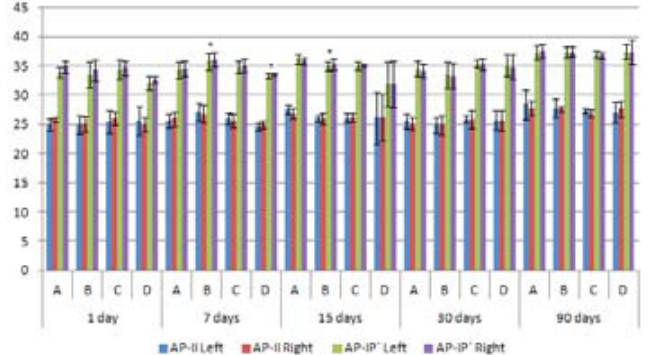
FIGURE 2 - Mean values and standard deviations (SD) of the cephalometric mensurations (mm) of the mandible of all the groups according to the experimental period. A=Control, B=DEX, C=MTX Low dose, D=MTX High dose. (*) Statistical difference between right and left